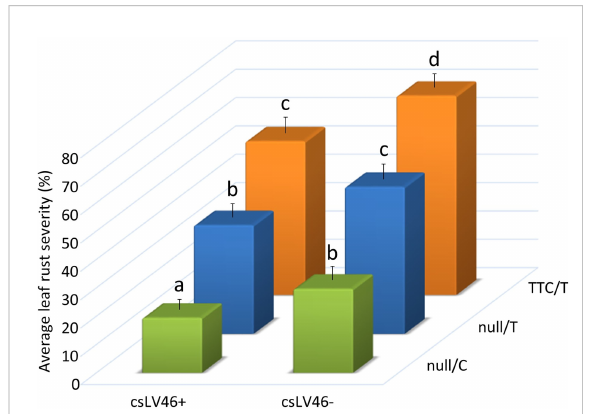
FIGURE 4 Average rust severity (%) of lines derived from crosses between Koktunkulskaja 332 and either Thatcher or its near-isogenic Lr34 line RL6058 where the lines are grouped according to their Lr34 and their csLV46 marker haplotypes. Marker csLV46 is linked to the leaf rust adult plant resistance gene Lr46 . Letters above the error bars indicate statistical signi fi cance ( P < 0.05).